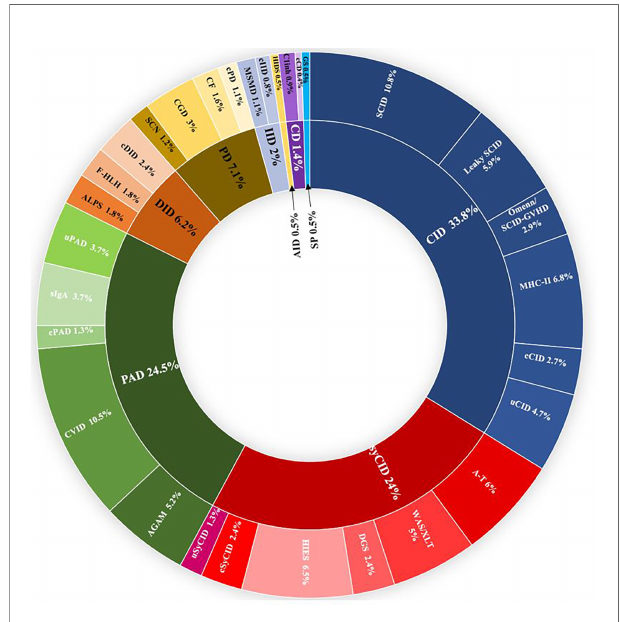
FIGURE 1 | Distribution of the frequencies of IEIs according to IUIS categories in 807 Algerian patients in the study. IEI groups are shown according to IUIS classi fi cation, 2021. Total number of patients and percentage of all registered patients are shown for each group. AGAM, agammaglobulinemia; ALPS, autoimmune lymphoproliferative syndrome; AID, autoin fl ammatory diseases; A-T, ataxia- telangiectasia; c, classi fi ed; CD, complement de fi ciencies; CF, cystic fi brosis; CGD, chronic granulomatous disease; CID, combined immunode fi ciencies; CVID, common variable immunode fi ciency; DGS, DiGeorge syndrome, DID, Dysregulation of immune diseases; f-HLH, familial Hemophagocytic lymphohistiocytosis; GS, good syndrome; HIES, hyper-IgE syndrome; HIDS, hyper-IgD syndrome; IID, innate immune de fi ciencies; MSMD, mendelian susceptibility to mycobacterial disease; PAD, predominantly antibody de fi ciencies; PD, phagocytic de fi ciencies; SCN, severe congenital neutropenia; sIgA; selective IgA de fi ciency; SP, Somatic phenocopies; SynCID, syndromic combined immunode fi ciencies; u, unclassi fi ed; WAS, Wiskott Aldrich syndrome; XLT, X linked